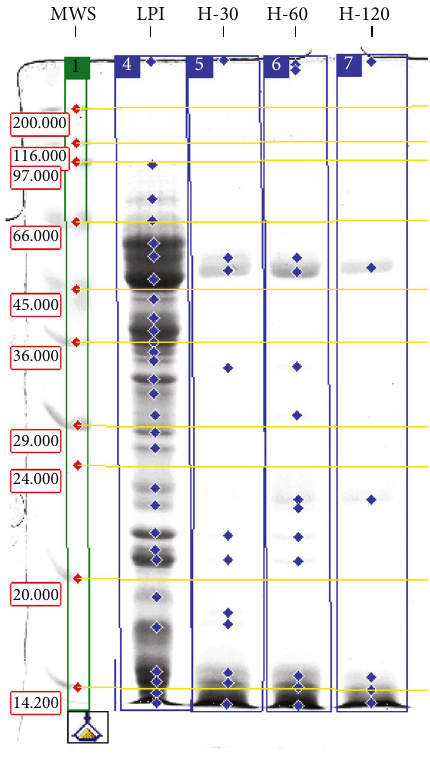
Figure 2: The results of SDS-PAGE of lupin protein preparations. Lanes: MWS: molecular weight standards (Da); LPI: lupin protein isolate; H-30, H-60, and H-120: LPI